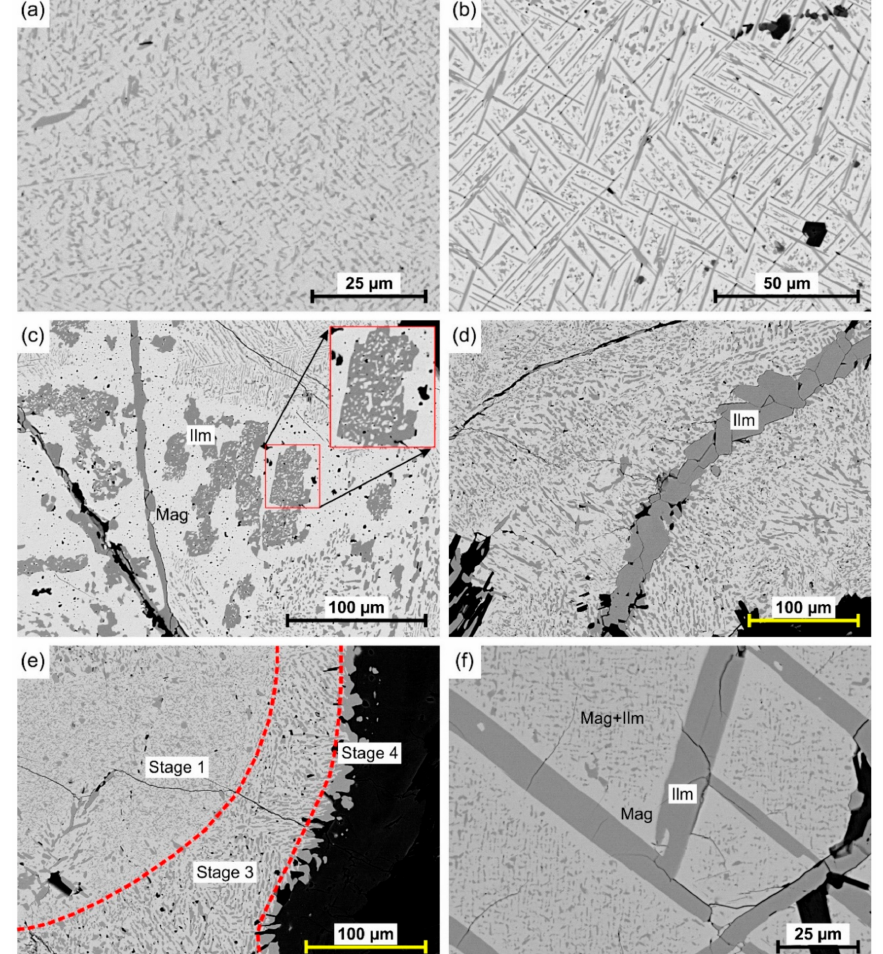
Figure 5. Backscattered electron images showing exsolutions of Ilmenite-E2 in titanomagnetite: ( a ) ilmenite pseudomorphous after cloth-like texture of ulvöspinel; ( b ) trellis-type lamellae of ilmenite with an interstitial, partly preserved, cloth-like texture; ( c ) composite intergrowths made of patchy exsolutions of ilmenite containing tiny blebs of magnetite (the red frame shows an enlargement of a composite intergrowth); ( d ) vermicular exsolutions in a titanomagnetite with a fracture filled with ilmenite granules; ( e ) a textural continuum from ilmenite pseudomorphous after cloth-like texture in the core of titanomagnetite (Stage 1), through vermicular exsolutions in the grain margins (Stage 3), to external granules (Stage 4); ( f ) thick lamellae of Ilmenite-E1 in cloth-textured titanomagnetite; note the absence of Ilmenite-E2 in the immediate vicinity of the lamellae. Refer to the text for the details on Stages 1, 3, and 4. Ilm, ilmenite; Mag,